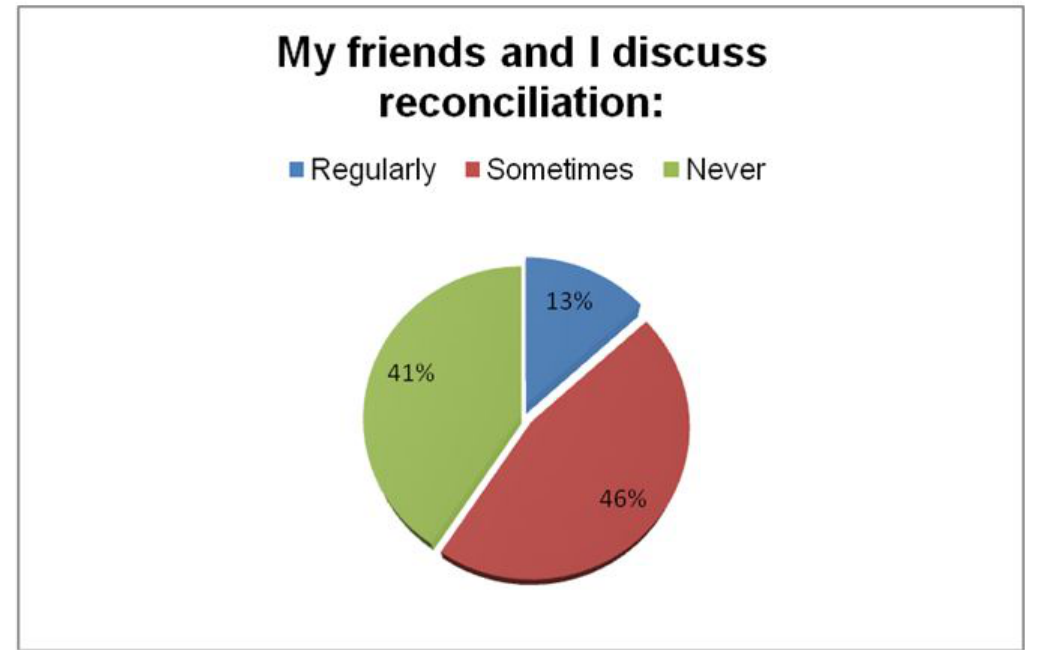
Figure 5: Students’ responses to how often they discuss reconciliation Deeper investigation revealed that 75% of White students and 40% of Coloured students never spoke about reconciliation compared to only 29.2% of Black students (Figure 6).